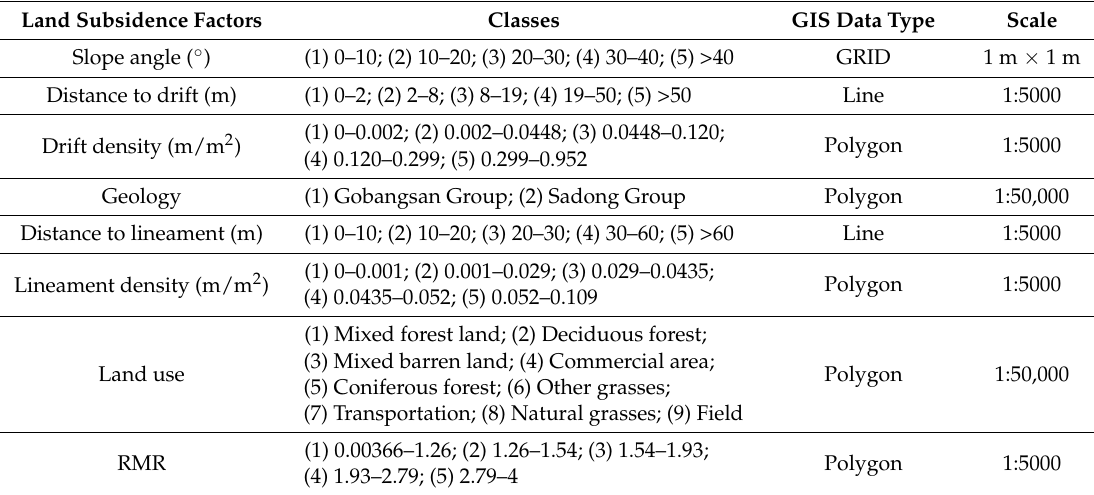
Table 1. Land subsidence conditioning factors and their